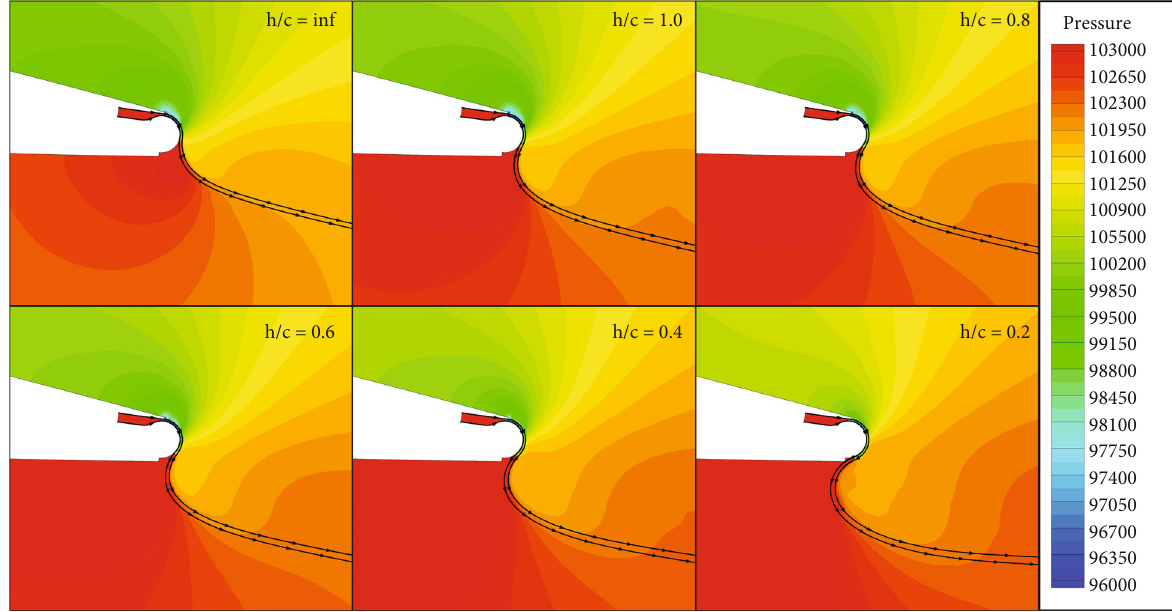
Figure 36: Pressure contours for α = 8 ° , NPR = 1 : 2 at various ride